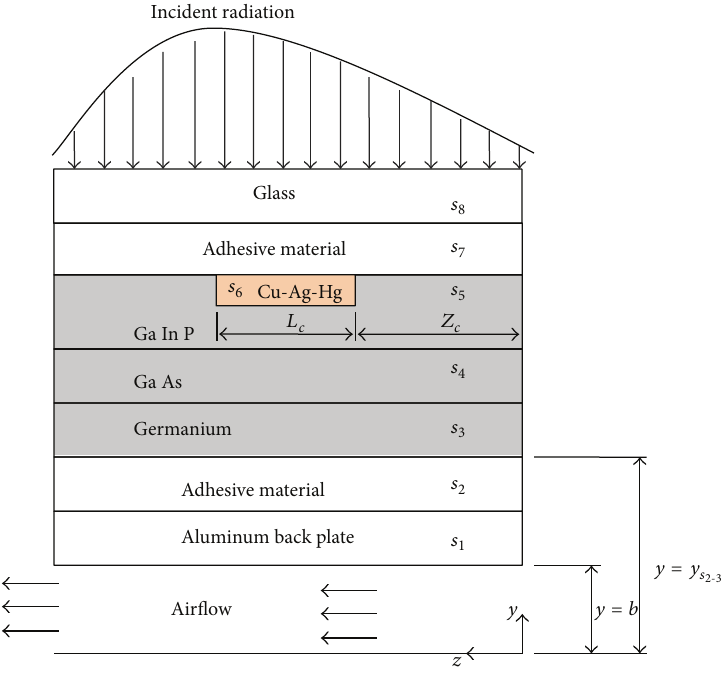
Figure 1: Schematic of the geometry of the employed system. Table 1: Thermophysical properties assumed in the